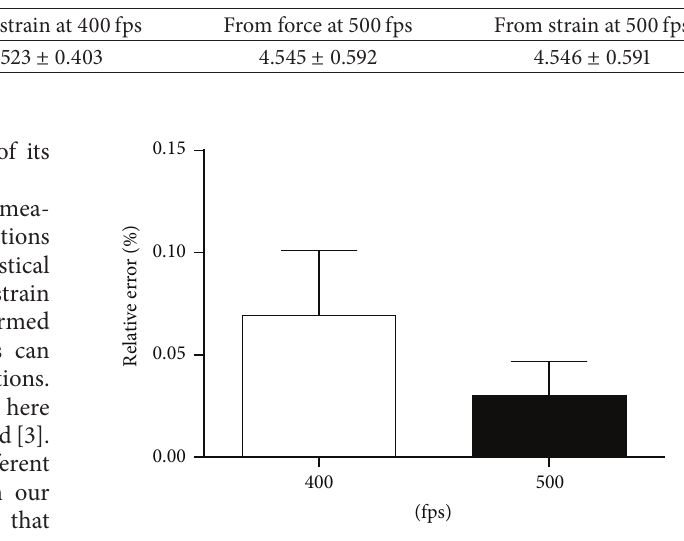
Figure 4: Relative error. Mean ± SEM of the relative error between the spontaneous contraction values measured through the tissue force response and the longitudinal strain behavior at 400 fps (white) and at 500 fps (black). 𝑛 = 4